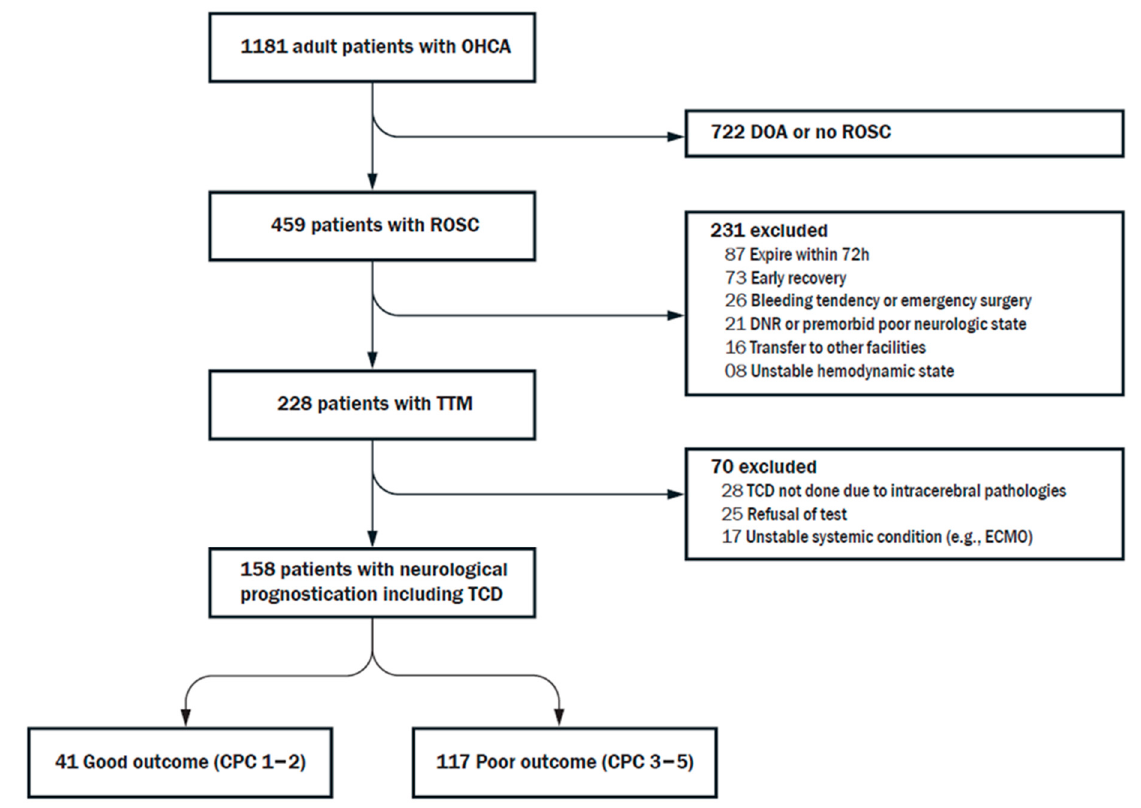
Figure 1. Flow chart. CPC, cerebral performance category; DOA, death on arrival; ECMO, extracorporeal membrane oxygenation; OHCA, out-of-hospital cardiac arrest; ROSC, return of spontaneous circulation; TCD, transcranial Doppler; TTM, targeted temperature management.